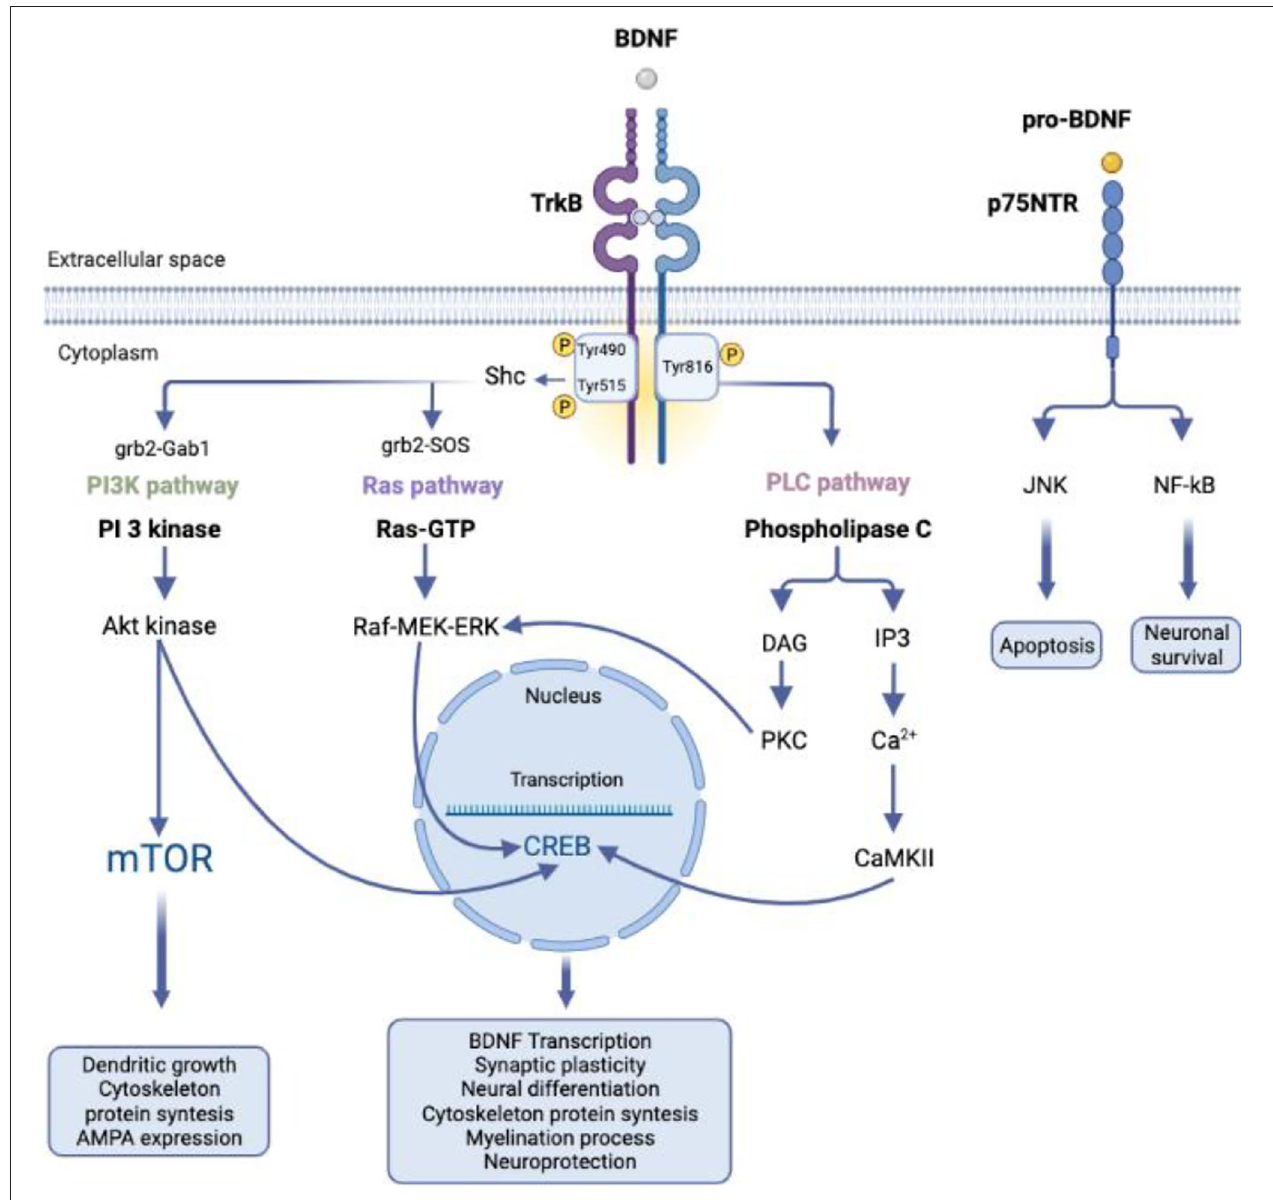
FIGURE 1 | TrkB and p75NTR signaling. The binding between BDNF and TrkB induces the activation of three transduction pathways at the intracellular level mediating their effects on neuronal growth and synaptic plasticity. The interaction between pro-BDNF and p75NTR receptor promotes cell apoptosis and neuronal survival via JNK NF-kB, respectively. BDNF, brain-derived neurotrophic factor; TrkB, tropomyosin receptor kinase; p75NTR, p75 neurotrophin receptor; Shc, Grb2, growth factor receptor-bound protein 2; SOS, Son of Sevenless; Gab1, GRB2-associated-binding protein 1; AKT, protein kinase B; PI3K, phosphatidylinositol 3-kinase; PLC, phospholipase C; PKC, protein kinase C; DAG, diacylglycerol; IP3, inositol-3-phosphate; CaMKII, type II calcium/calmodulin-dependent protein kinase; JNK, c-Jun N-terminal kinases; NF-kB, nuclear factor kappa B; CREB, cAMP response element-binding protein; mTOR, mammalian target of rapamycin; AMPA, α -Ammino-3-idrossi-5-Metil-4-isossazol-Propionic Acid.